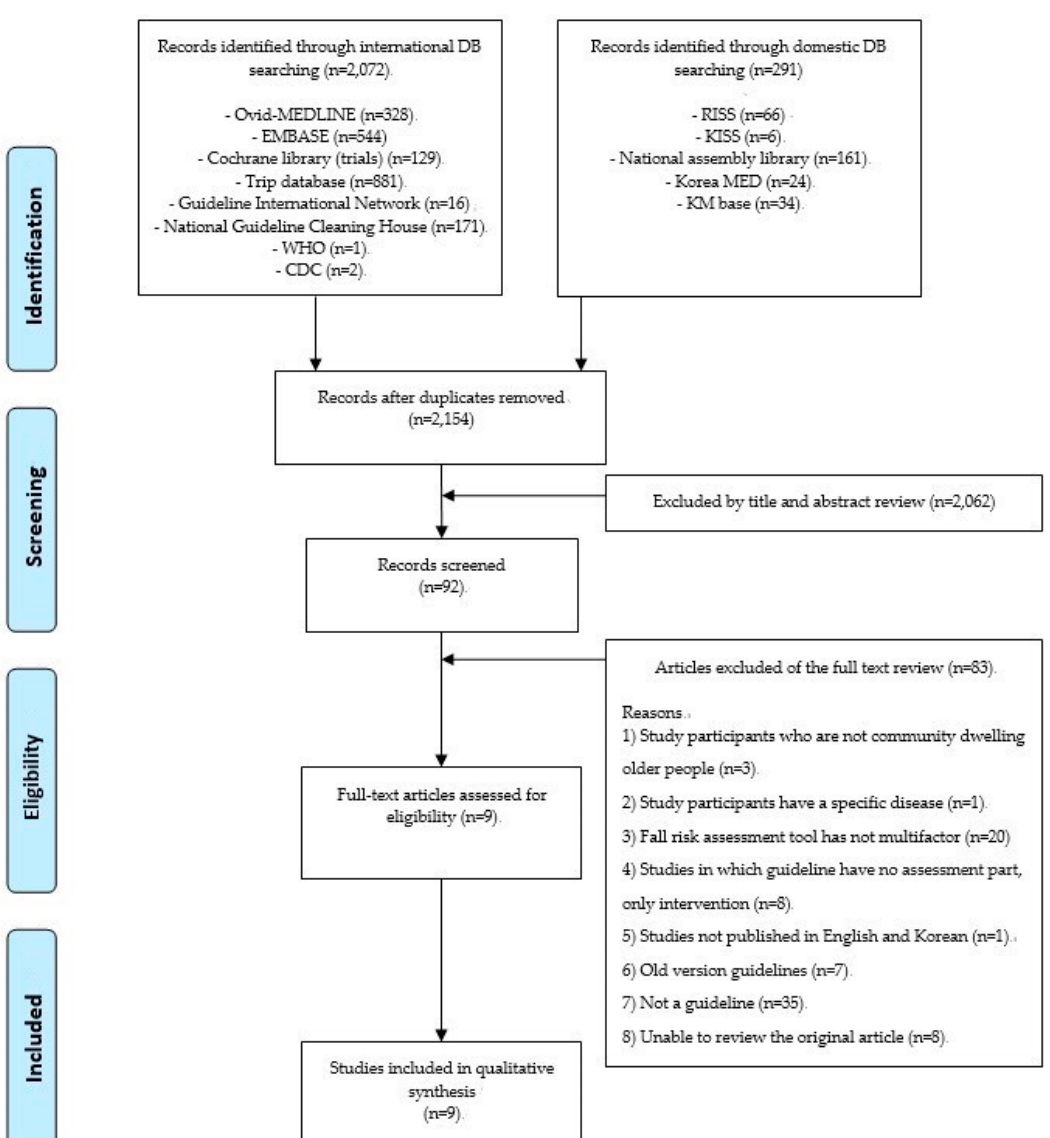
Figure 1. Updated flow chart. Notes: DB = Data Base; WHO = World Health